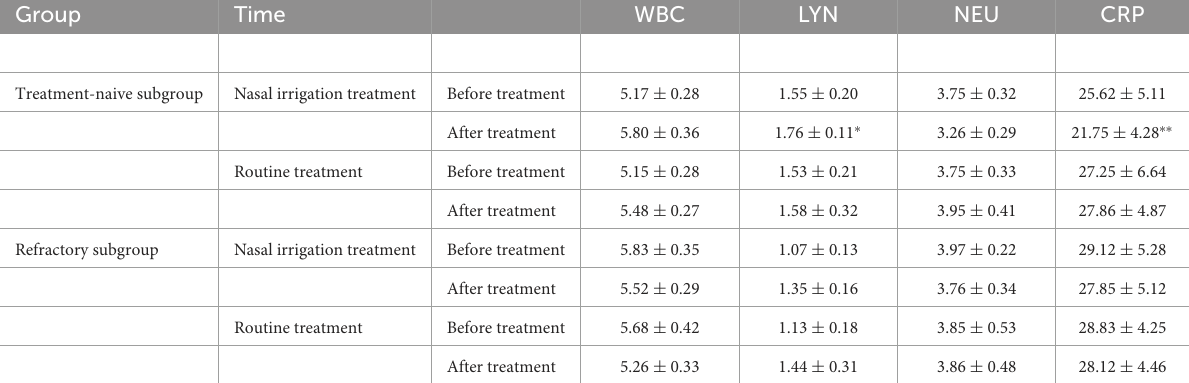
TABLE 7 Changes of blood routine and CRP indexes in the treatment-naïve subgroup and refractory subgroup before and after treatment. Group